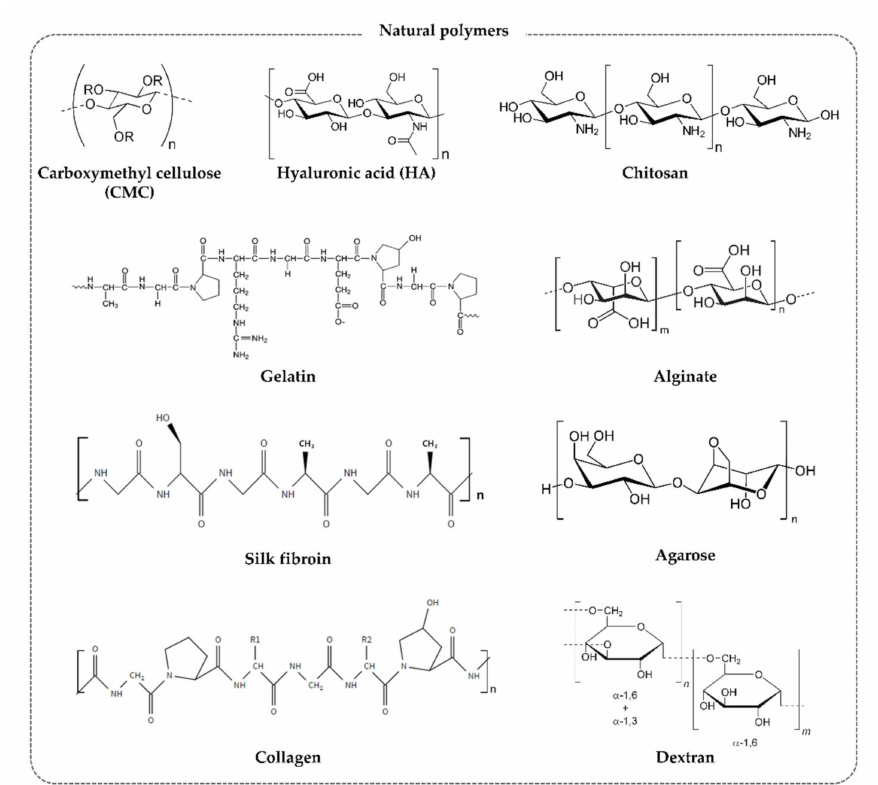
Figure 3. Structures of natural polymers (the image of the gelatin structure was adopted with permission